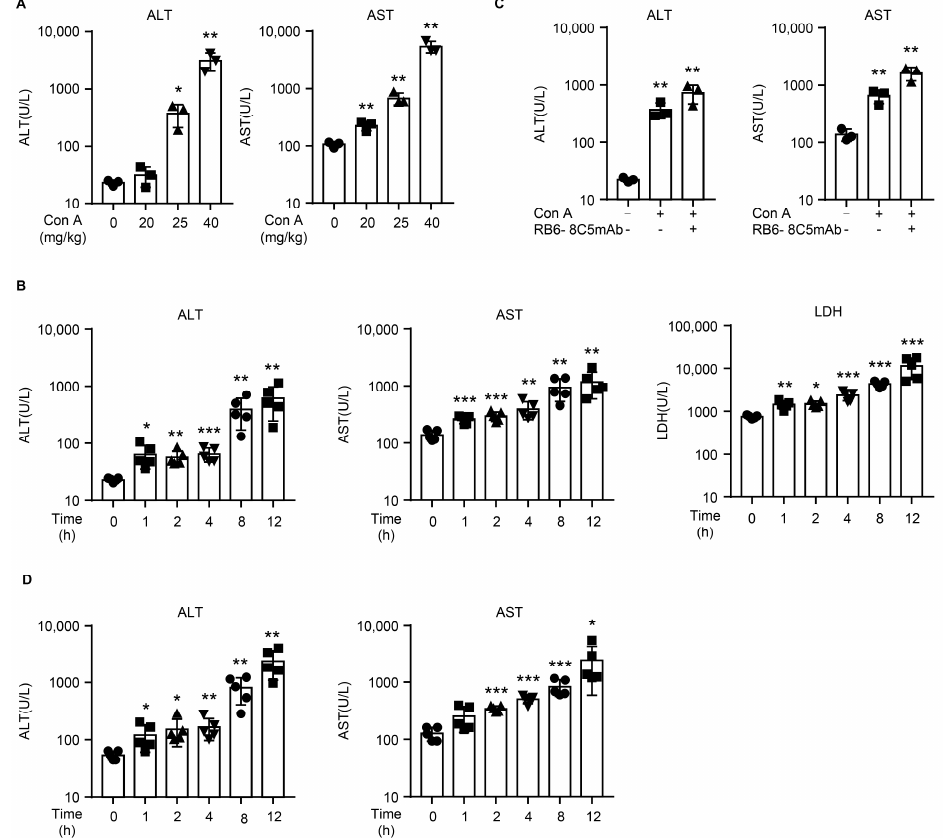
Figure 1. Con A induces liver injury in NOD SCID mice. NOD SCID or BALB/c mice were intravenously injected with Con A (20 mg/kg, 25 mg/kg, or 40 mg/kg of body weight) or saline solution as a mock injection (negative control), and serum samples were collected 1, 2, 4, 8, and 12 h after injection for the following analyses: ( A ) Serum levels of alanine aminotransferase (ALT) and aspartate aminotransferase (AST) 8 h after Con A injection ( n = 3 for each group). ( B ) The plasma concentrations of ALT, AST, and lactate dehydrogenase (LDH) in NOD SCID mice ( n = 5 for each group) intravenously injected with Con A at 25 mg/kg of body weight or saline solution at various time points. ( C ) NOD SCID mice ( n = 3 for each group) pretreated with RB6-8C5 mAb before Con A injection, and the plasma concentrations of AST/ALT detected at 8 h post-Con A treatment. ( D ) Plasma concentrations of ALT/AST in BALB/c mice ( n = 5 for each group) intravenously injected with Con A at 25 mg/kg of body weight or saline solution at various time points. Bar graphs show means ± SD. Each symbol represents one individual. *, p < 0.05; **, p < 0.01, and ***, p < 0.001 vs. the control group.